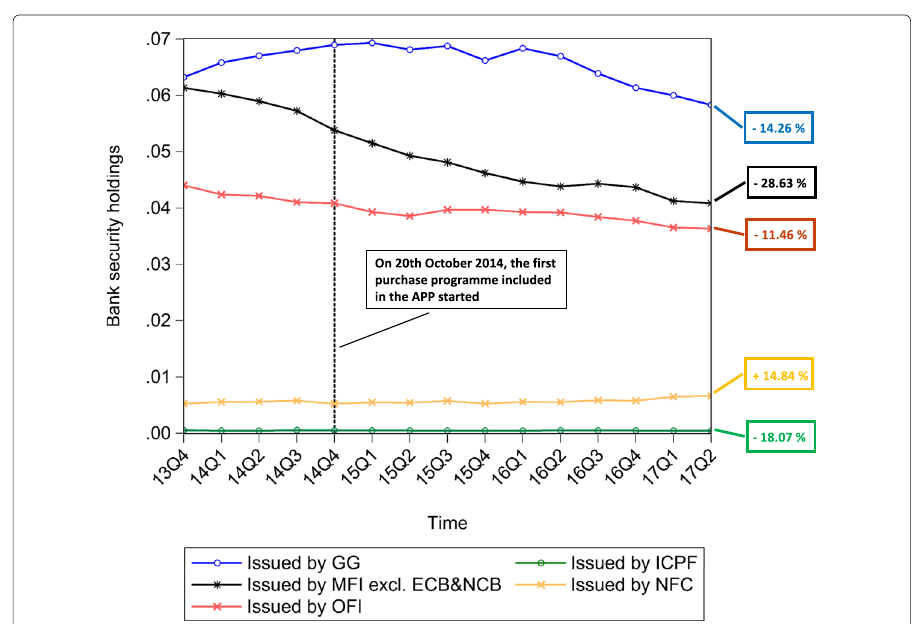
Fig. 13 Bank security holdings - breakdown by counterparty sector; 2013Q4-2017Q2. Time series of the breakdown of debt securities (including short-term and long-term private and public securities) held by the euro area Monetary Financial Instutions excluding the Eurosystem by issuing counterparty sector, i.e., Monetary Financial Institutions excluding the Eurosystem (MFI excl. ECB&NCB, in black), Other